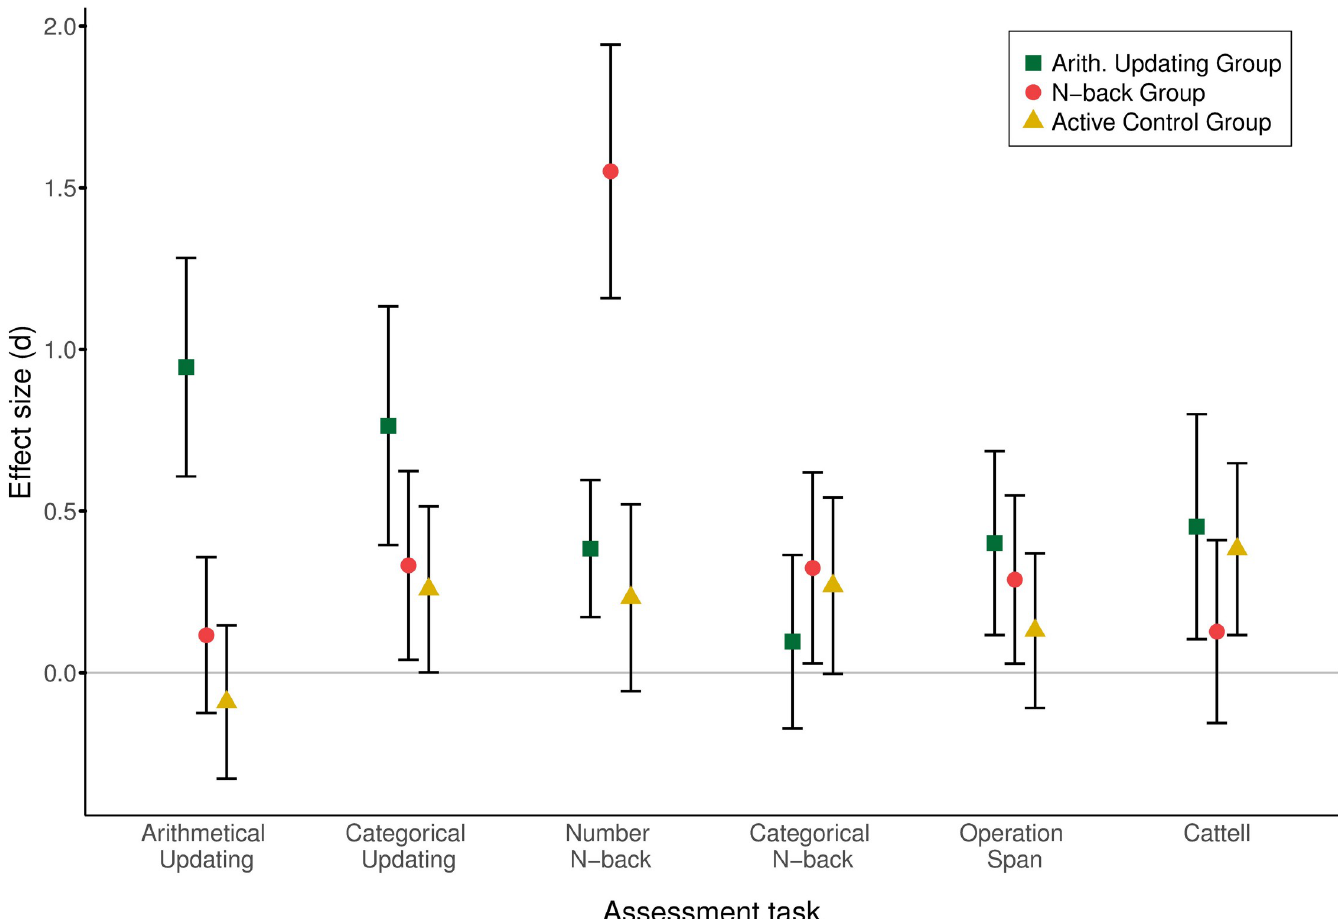
Fig 4. Effect sizes for each assessment transfer task by group (arithmetical, n -back, active control).